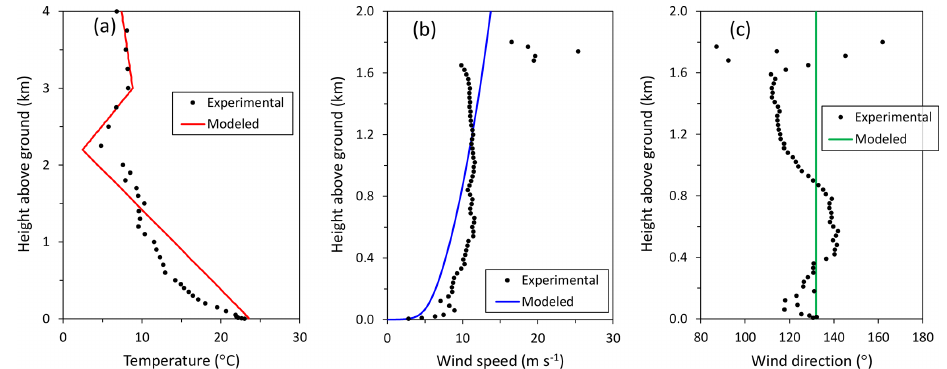
Figure 4. Experimental (black circles) and modeled (solid red, blue, and green lines) vertical profiles of (a) temperature, (b) wind speed, and (c) wind